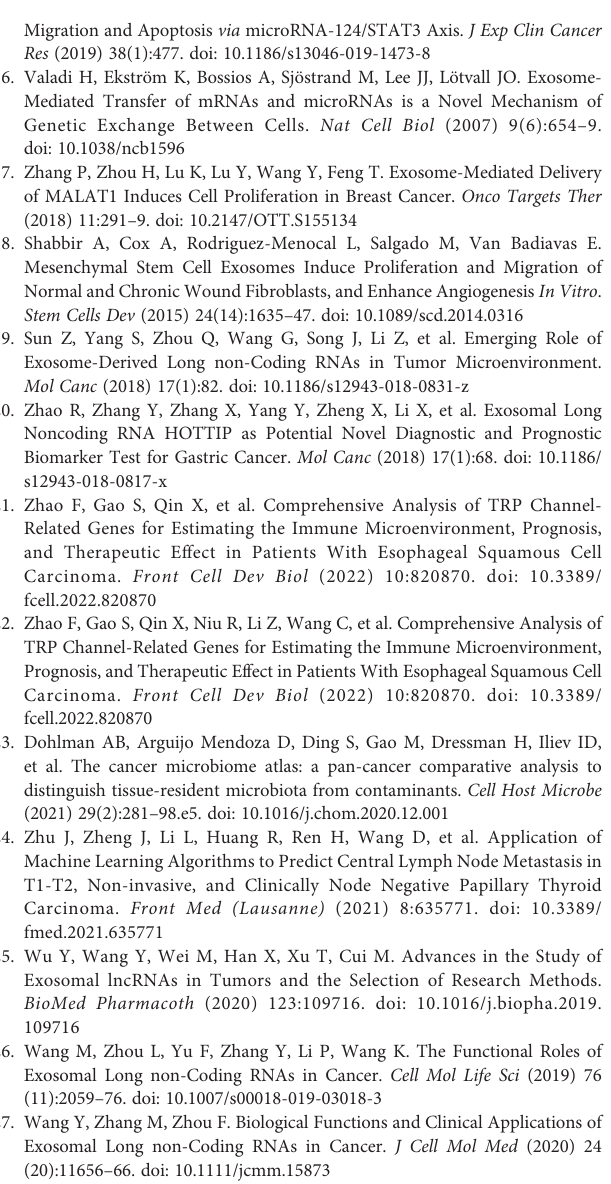
Supplementary Figure 1 | The GSVA pathway enrichment analysis between different subtypes. Supplementary Figure 2 | The results of the univariate and multivariate Cox regression analyses regarding signi fi cant survival-related clinical characteristic parameters in TCGA. Supplementary Figure 3 | Heat map showing the difference in the TME between the low- and high-risk